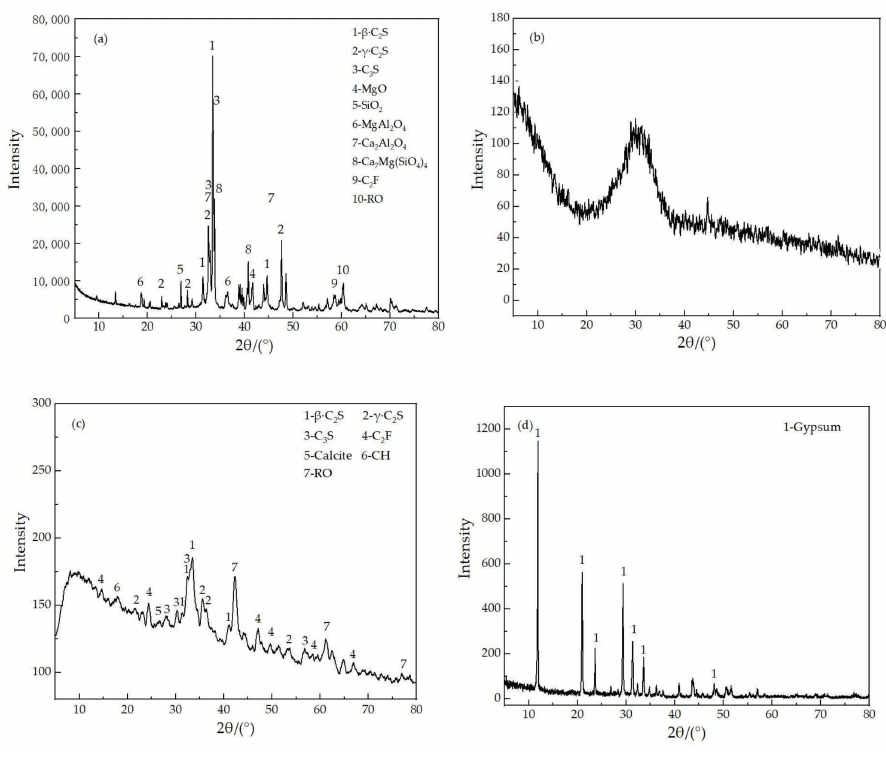
Figure 2. XRD patterns of raw materials: ( a ) LCFS; ( b ) GBFS; ( c ) SSM; ( d ) FGDG.